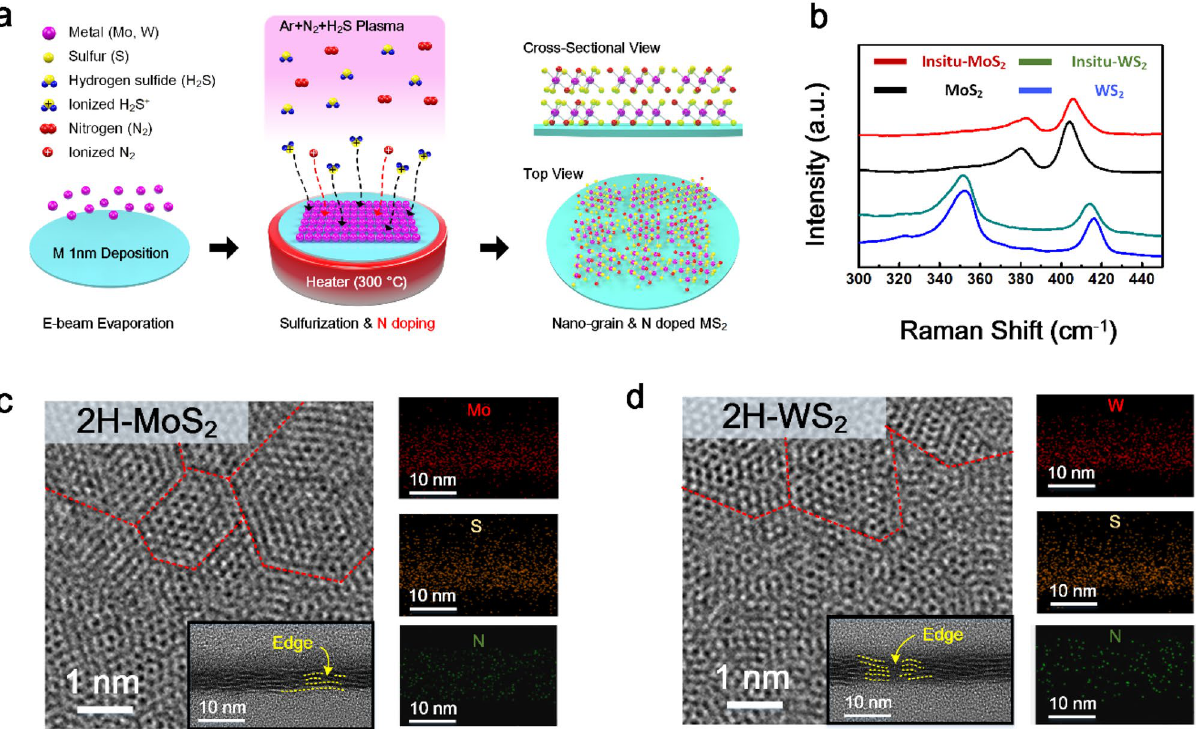
Figure 1. ( a ) Illustration of in situ-doping process during TMD fabrication, ( b ) Raman spectra of pristine TMD and N doped TMD thin films. TEM image of ( c ) in situ-MoS 2 and ( d ) in situ-WS 2 samples. Red lines are drawn along with the grain boundary. Inset figures present the cross-sectional TEM images of TMD thin films. EDS images corresponding to each element are arranged vertically on the right